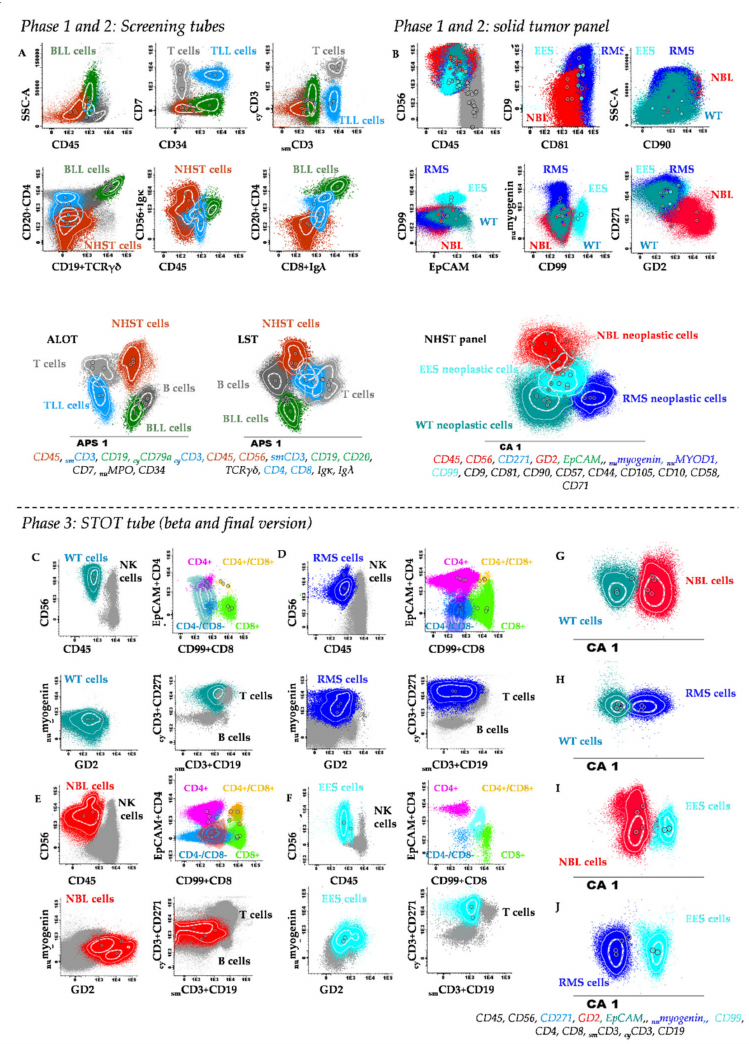
Figure 2. Flow cytometric identification and characterization of normal/reactive immune cells vs. hematopoietic and non-hematopoietic tumor cells with the antibody panel used in phases 1 and 2 ( A , B ) and in phase 3 ( C – J ) of the study. ( A ) Conventional bivariate dot plots and APS diagrams showing merged data files containing distinct subtypes of CD45 − CD56 + non-hematopoietic solid tumor cells (NHST) (dark red events), B lymphoblastic lymphoma cells (BLL) (green events), T lymphoblastic lymphoma cells (TLL) (blue events), and normal immune cells (grey events) from solid tumor samples stained with the screening tubes. ( B ) Solid tumor antibody panel used in phase 1 and 2 of the study, showing tumor cells of distinct NHST subtypes—neuroblastoma (NBL) (red dots), rhabdomyosarcoma (RMS) (dark blue dots), extraosseous Ewing sarcoma (EES) (light blue dots), Wilms tumor (WT) (petrol blue dots). In panels A and B, the most informative markers for identification of tumor cells and their subclassification with both sets of antibody combinations are shown in red, blue, and green at the bottom of the corresponding APS diagram. ( C – J ) Samples stained with STOT in phase 3 of the study are shown. Bivariate dot plots of distinct combination of the STOT markers for discrimination between residual immune cells (colored grey, pink, light green, and/or yellow) and tumor cells contained in merged data files of WT (petrol blue dots), RMS (dark blue dots), NBL (red dots) and EES (light blue dots) are shown in plots ( C – F ), respectively. Multivariate canonical (CA) analysis of the overall 1 × 1 comparisons between the phenotype of: ( G ) WT (petrol blue dots) vs. NBL (red dots); ( H ) WT (petrol blue dots) vs. RMS (dark blue dots); ( I ) NBL (red dots) vs. EES (light blue dots); and ( J ) RMS (dark blue dots) vs. EES (light blue dots) are shown in panels G to J, respectively. At the bottom of these later plots, the most informative STOT markers discriminating the above tumor subtypes are